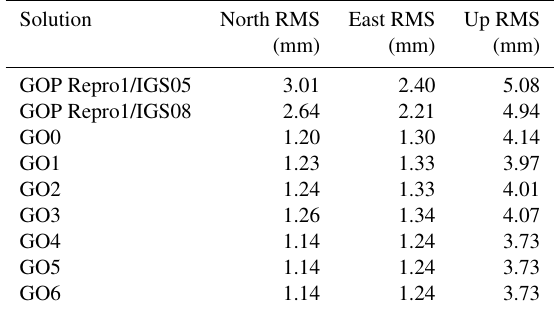
Table 3. Comparison of GOP solution variants for north, east and up coordinate